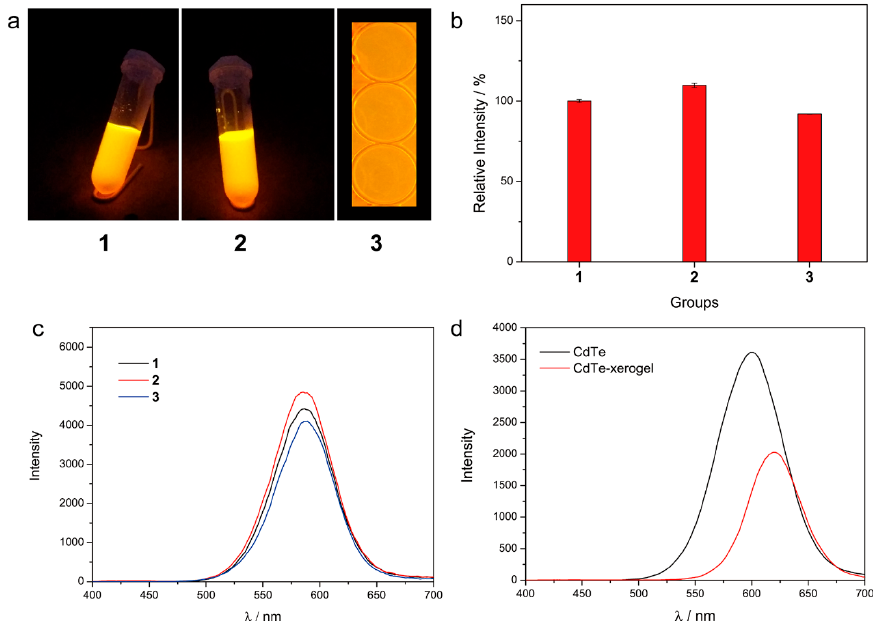
Figure 3. The fluorescence property of the xerogels. ( a ) photographs of β CD-CdTe ( 1 , 20 mg/mL), HEMA-Ad@ β CD-CdTe ( 2 , 20 mg/mL) and the corresponding xerogel ( 3 ) under ultraviolet light ( λ ex = 365 nm); ( b ) the relative fluorescence intensity of 1 , 2 and 3 , in which the fluorescence intensity of 1 is set as 100%; ( c ) fluorescence spectra of 1 , 2 and 3 ; and ( d ) fluorescence spectra of CdTe (20 mg/mL) and the corresponding xerogel (CdTe-xerogel). For all the fluorescence spectra, the excitation wavelength is 380 nm.